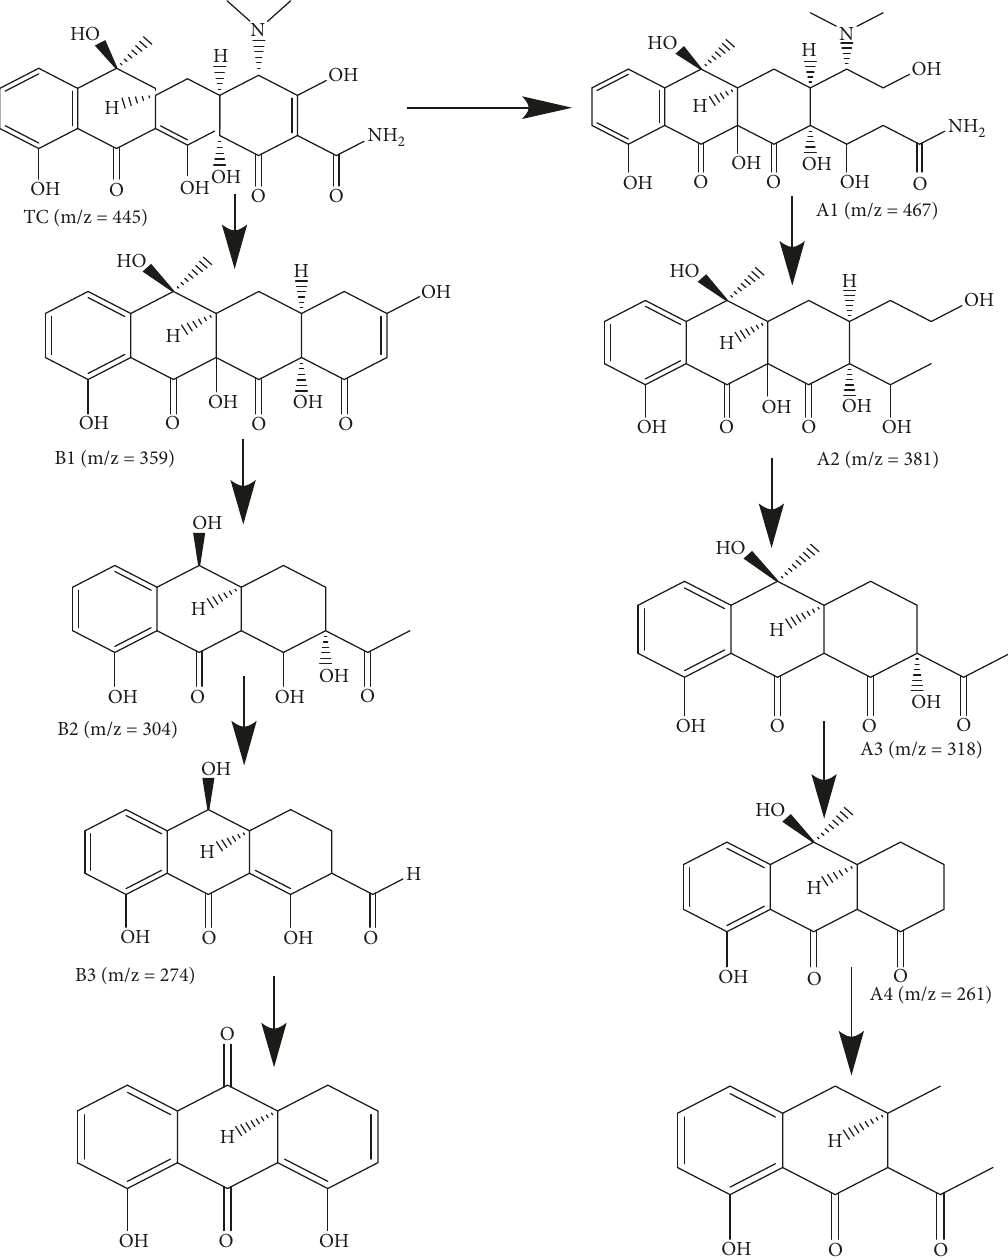
Figure 13: The proposed sonophotocatalytic tetracycline degradation